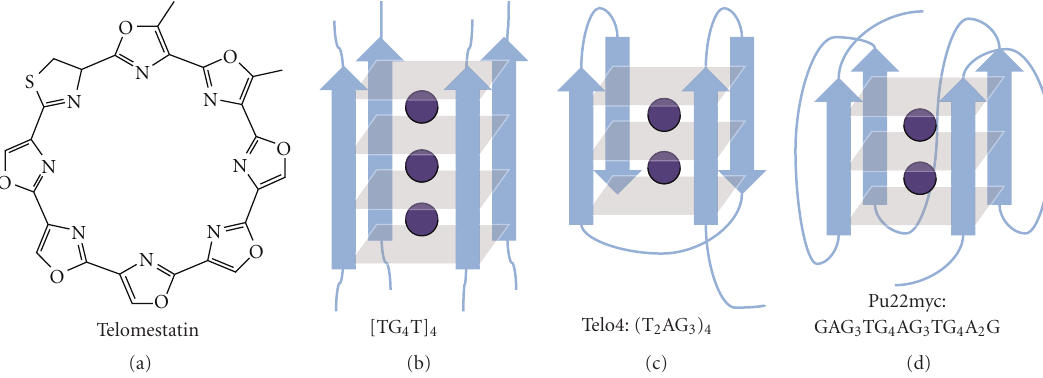
Figure 1: Chemical structure of telomestatin and folding pattern of the three G-quadruplexes studied here. [TG 4 T] 4 adopts a parallel fold and can incorporate three ammonium ions between its four G-quartets [21], the 4-repeat telomeric sequence (T 2 AG 3 ) intramolecular antiparallel fold in ammonium acetate and incorporates up to two ammonium ions [22], and the Pu22myc promoter sequence GAG 3 TG 4 AG 3 TG 4 A 2 G adopts a predominantly parallel fold in ammonium acetate and incorporates two ammonium ions